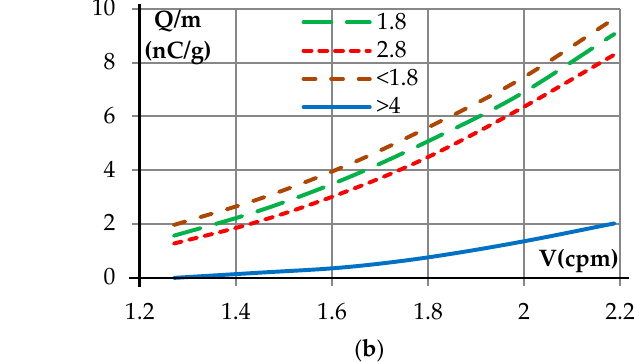
( b ) Figure 13. Charge density per mass as a function of airflow for tribocharging process of ( a ) PET, size of material 1.8–2.8 mm in the container made of PP, ABS, ASA, PLA; ( b ) PE-HD, size of material 1.8–2.8 mm, in the container made of PET-G, ABS, ASA and PP for a constant time of the charging process t = 30 s for fraction mass 10 g. In further investigations, several separation tests were performed on a physical mixture of the two polymers with a particle size of 1.8–2.8 mm, with a weight share of 50% each. Such a particle size of the polymers can be electrified very well. First, the sep- aration ability of such a 100 g mixture (50 g PET + 50 g PE-HD) was tested without a tri- bocharging process. In 17 boxes of material collectors, the separated particles accumu- lated mainly in one place with a small number of PET particles deflected towards the positive electrode of the separator (Figure 14a). Due to similar electrification effects of both polymers in ASA, PLA, PET-G, and ABS tribocharging containers, further separa- tion tests of the mixture for both polymers were performed in PET-G, ASA and PP tri- bocharging containers. The tribocharging time was 60 s and the airflow was 2.19 cpm. The results of these trials are summarized in Figure 14b–c, while the evaluation of the